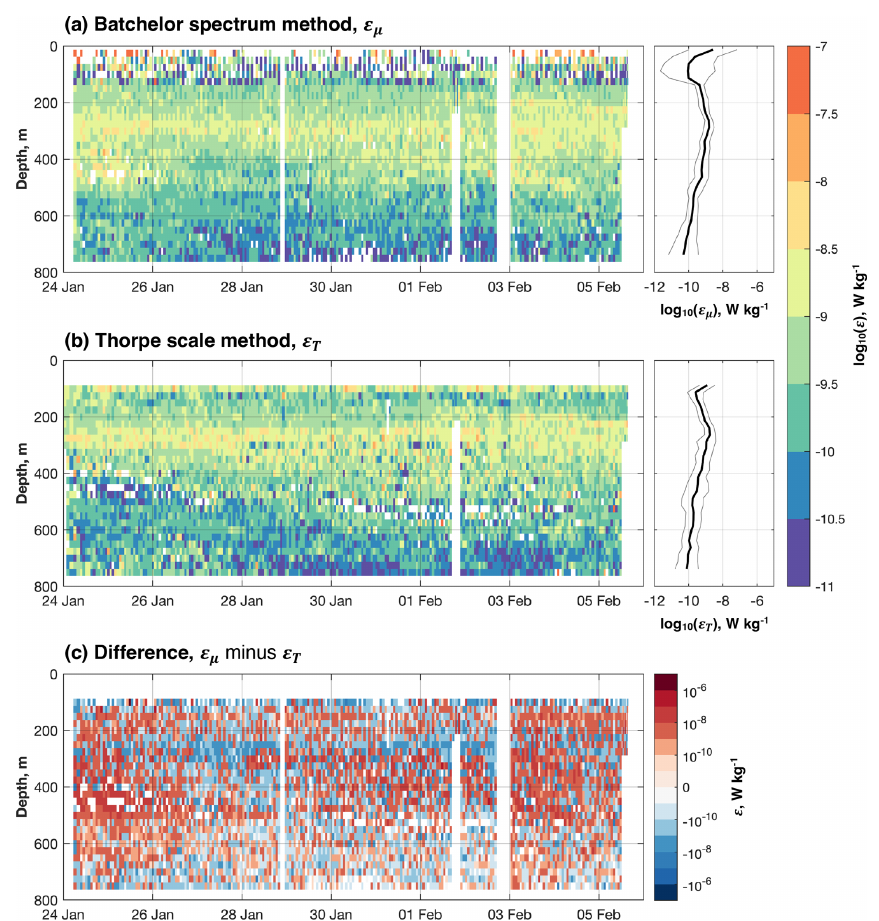
Figure 5. Turbulent kinetic energy dissipation rate, ε (Wkg − 1 ), as estimated using (a) the Batchelor spectrum method ( ε µ ) and (b) the Thorpe scale method ( ε T ). The respective geometric means (thick lines) and geometric standard deviation factors (thin lines) are shown in the panels on the right. Note that geometric standard deviation factor is multiplicative. (c) The difference between ε µ and ε T